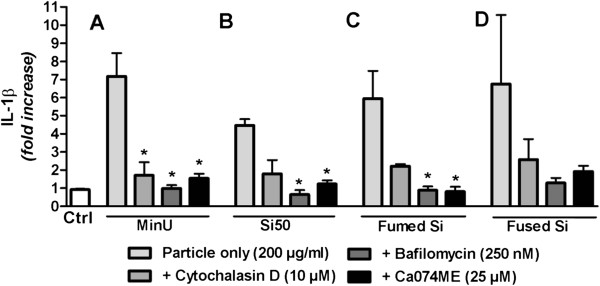
Involvement of uptake and lysosomes in inflammasome activation by non-crystalline and crystalline silica in RAW264.7 macrophages. The cells were primed for 3 h by LPS (25 ng/ml), and then pre-treated for 30 min with the indicated concentrations of cytochalasin D, bafilomycin or Ca074Me before exposure to different silica particles (200 μg/ml) for 6 h. A) MinUsil 5 (MinU); B) Si50 C) Fumed silica particles D) Fused silica particles. The IL-1β levels were determined by ELISA. Data represent the mean ± SD of 6 experiments and are presented as fold change. * = p < 0.05; significant different from particle-stimulated cells without inhibitors (light grey bars); using Kruskal-Wallis test with Dunn’s Multiple Comparison test as a post-test.